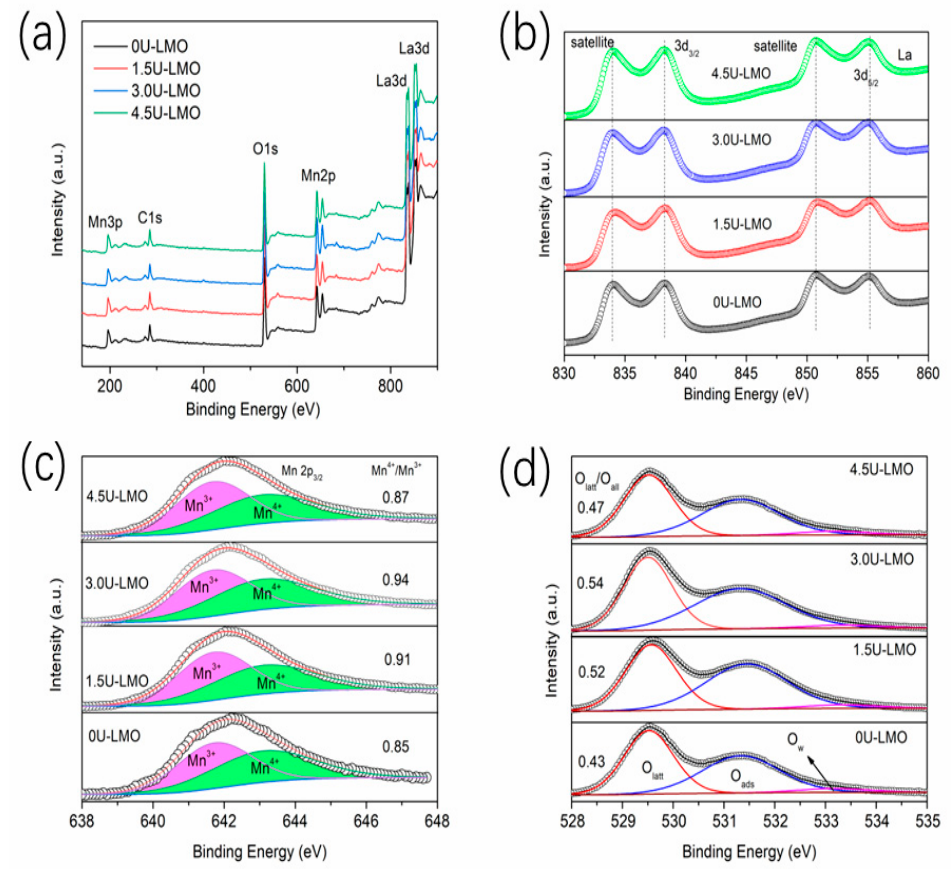
Figure 4. ( a ) XPS spectra, ( b ) La 3d levels, ( c ) Mn 2p 1/2 levels, and ( d ) O 1s levels of xU-LMO (x = 0, 1.5, 3.0, and 4.5) samples.